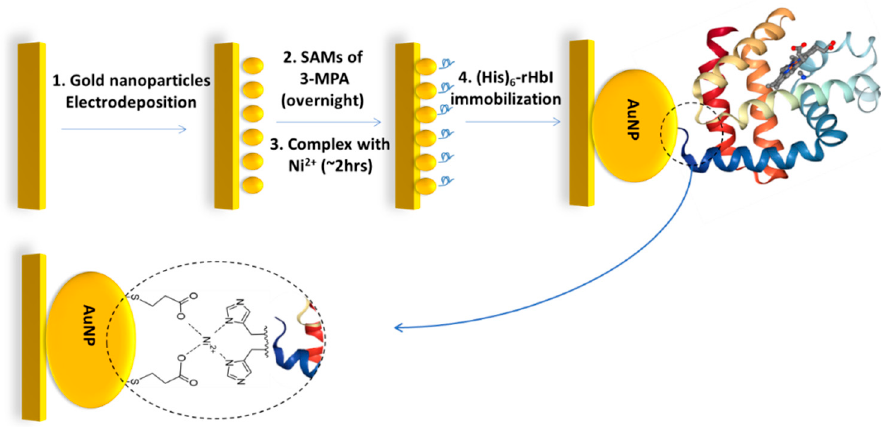
Figure 1. Schematic procedure of gold electrode modification steps for the (His) 6 -rHbI protein immobilization over AuNPs via polyhistidine-tag with 3-MPA/Ni 2+ complex.